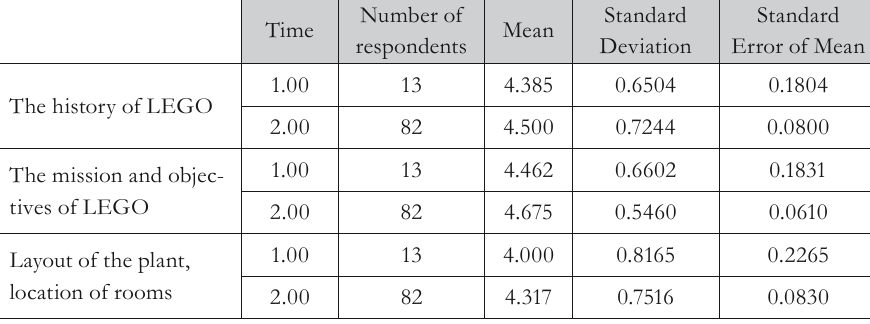
Tab. 1 – Descriptive statistics of questions focused on the knowledge of workers. Source: Author’s